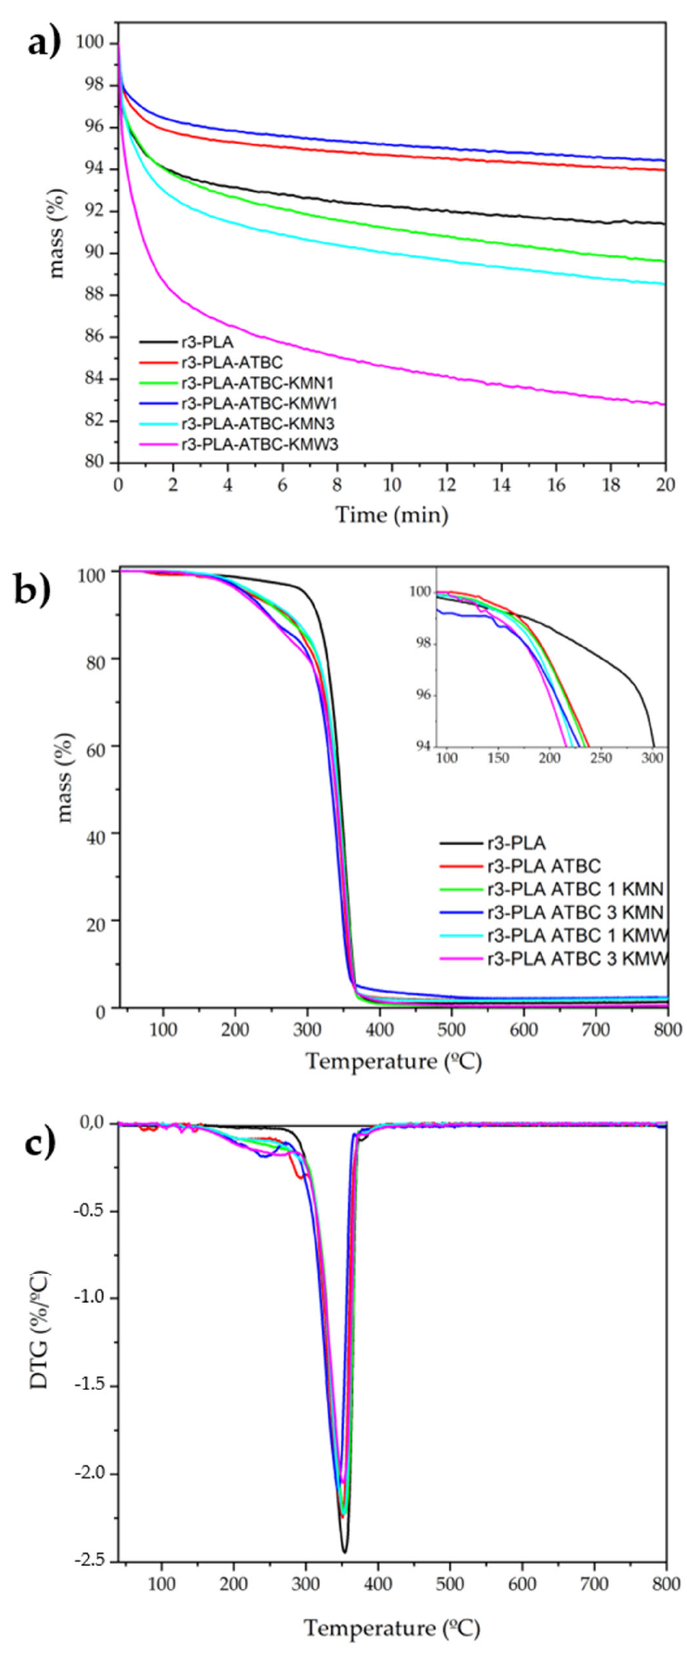
Figure 5. ( a ) Isothermal TGA analysis at 180 °C and Dynamic TGA ( b ) and DTG ( c ) of 3r ‐ PLA ‐ ATBC ‐ based films.